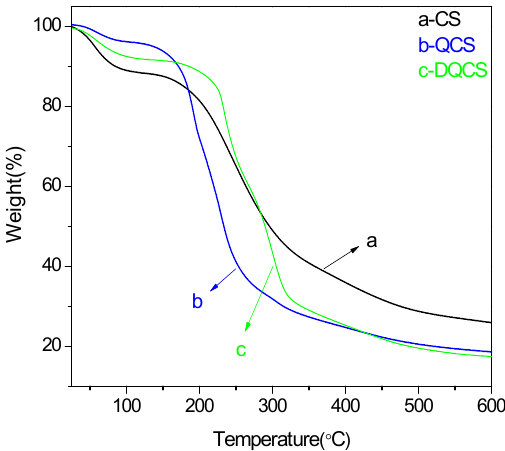
Figure 3. TGA thermogram curves. ( a ) CS; ( b ) QCS; ( c ) DQCS.